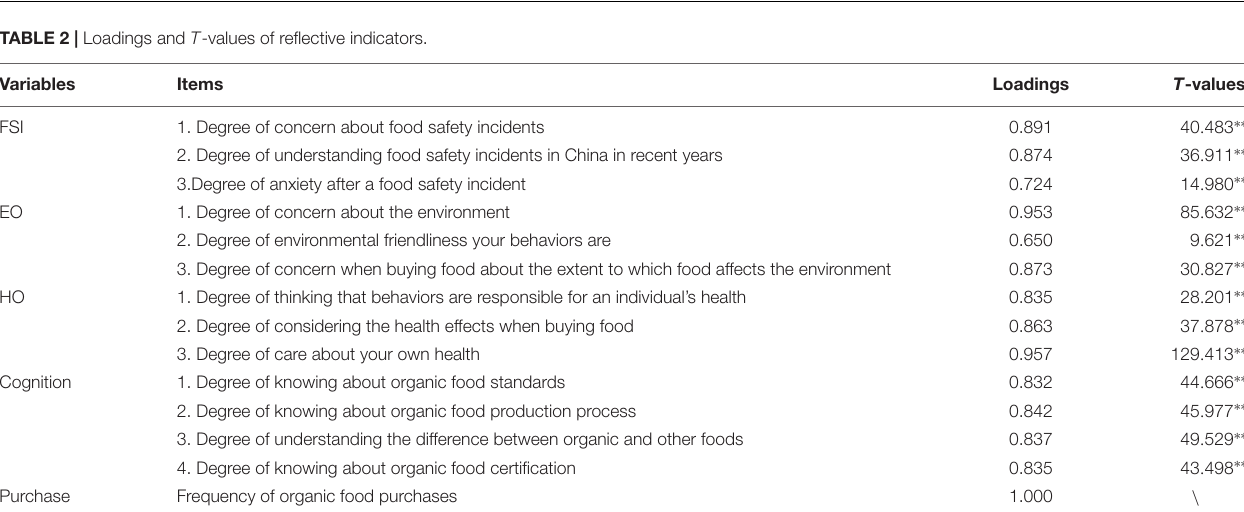
FIGURE 2 | The PLS model for assessing common method variance.